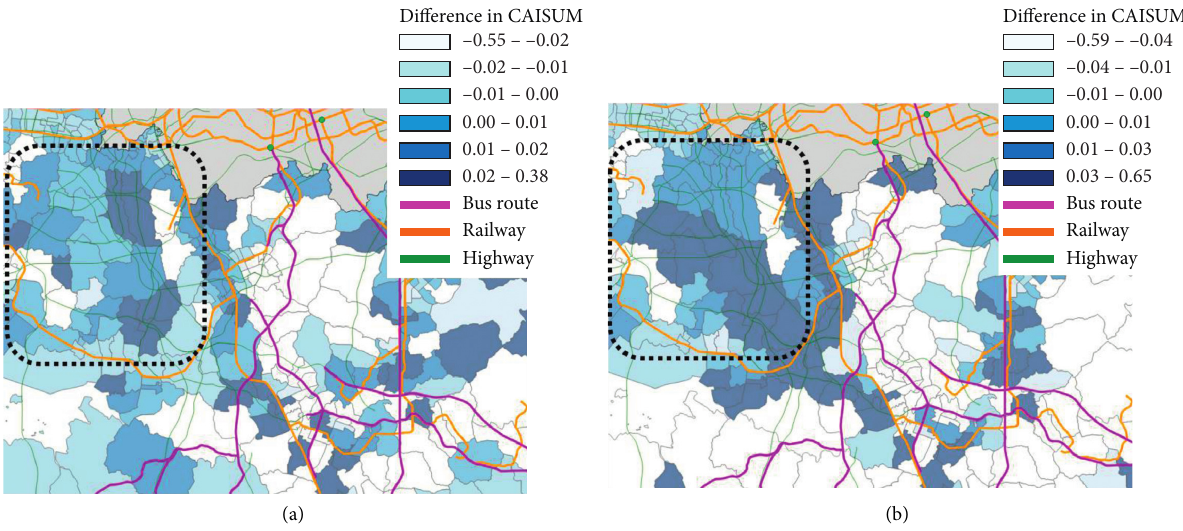
Figure 7: A difference in the CAISUMs between neighboring zones with regional transits (express bus routes and railway): (a) compared with zones in 5km; (b) compared with zones in 10